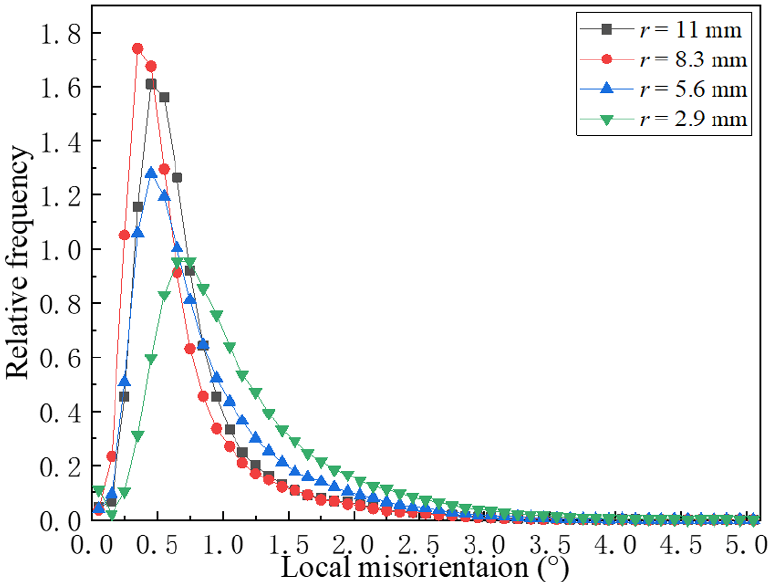
Figure 7. Local misorientation distribution of the forged tube with a reduction of 42.7%.